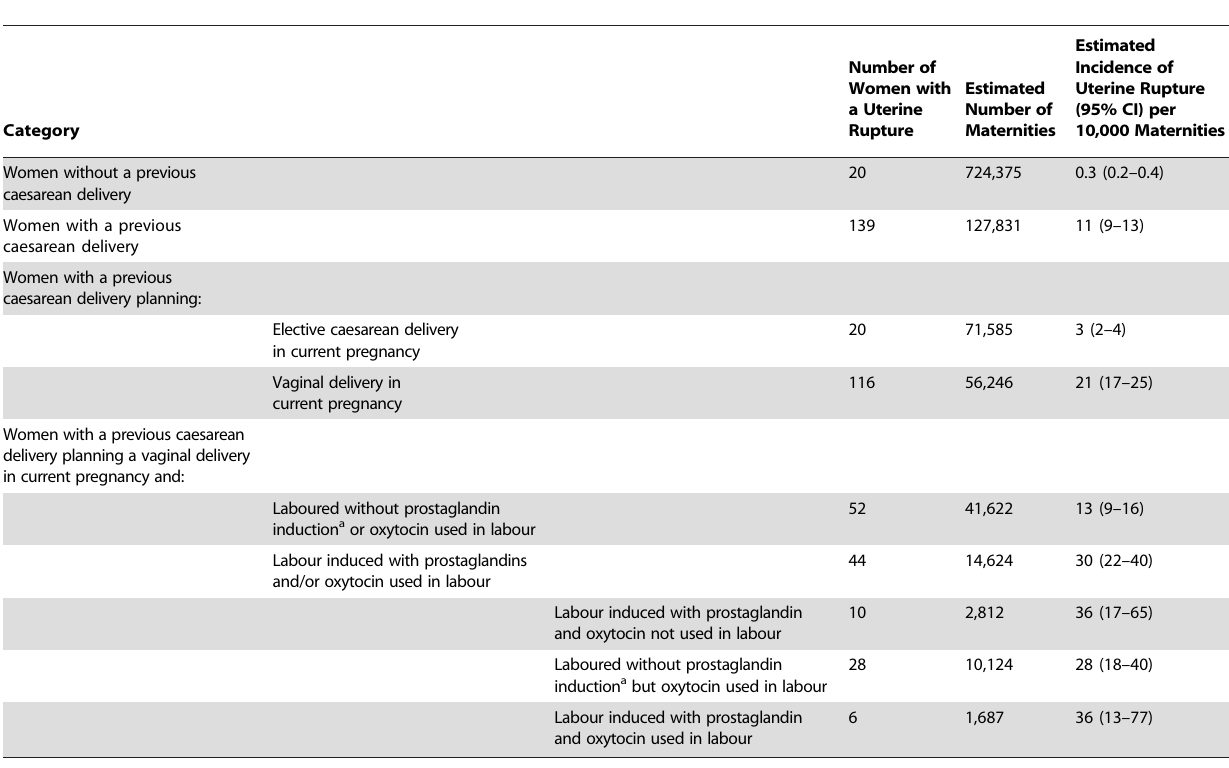
Table 1. Estimated incidence of uterine rupture in different categories of women.